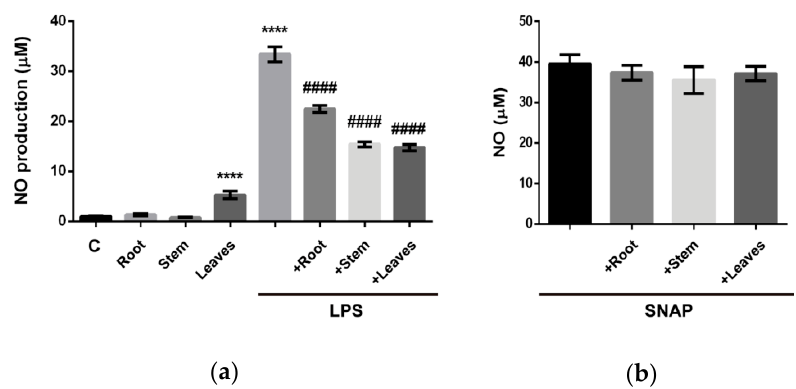
Figure 2. Evaluation of the capacity of G. tridentata extracts to modulate NO production in Raw 264.7 macrophages. ( a ) Levels of NO in supernatants from cells stimulated with extracts or with extracts and LPS. ( b ) Assessment of the potential of NO scavenging activity through the SNAP assays. Data is presented as concentration of NO and represent mean ± SD from three independent biological experiments. (**** p < 0.0001: control vs. LPS; #### p < 0.0001: LPS vs. extracts + LPS). Data is presented as percentage of control (nontreated cells / medium) and represent the mean ± SD from at least three independent experiments.